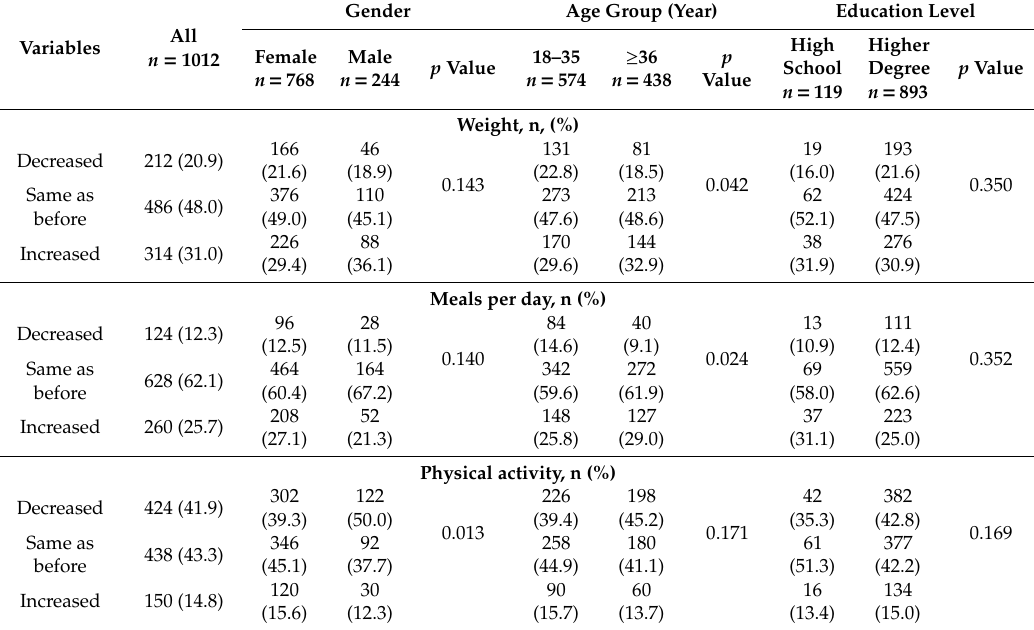
Table 9. Lifestyle changes during COVID-19 pandemic by demographic factors ( n =